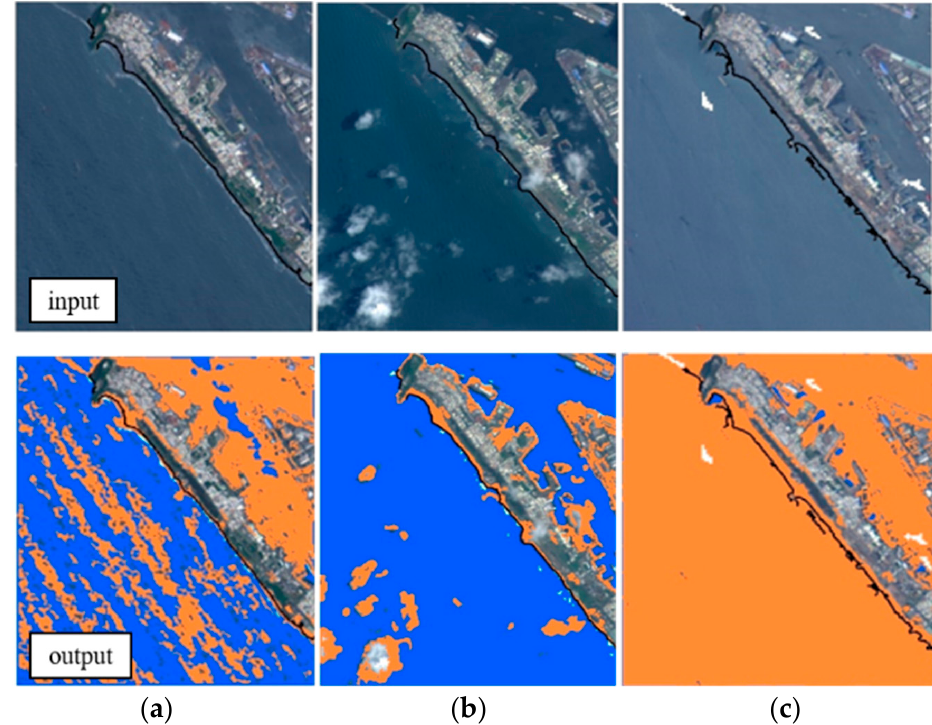
Figure 1. Misclassification results of sea–land segmentation on the Kaohsiung Port of ( a ) waves, ( b ) clouds, and ( c ) fog.